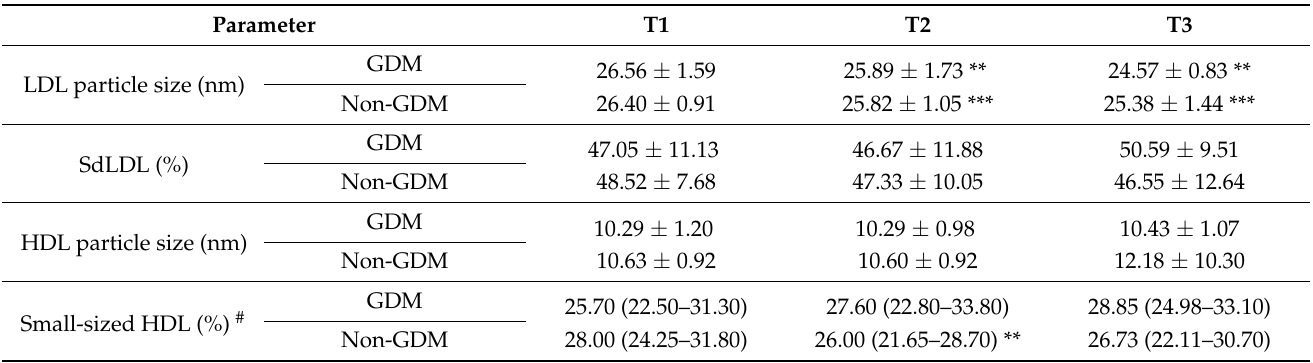
Table 5. Pattern of changes in lipoprotein subclasses size and distribution across trimesters in pregnant women with and without GDM.